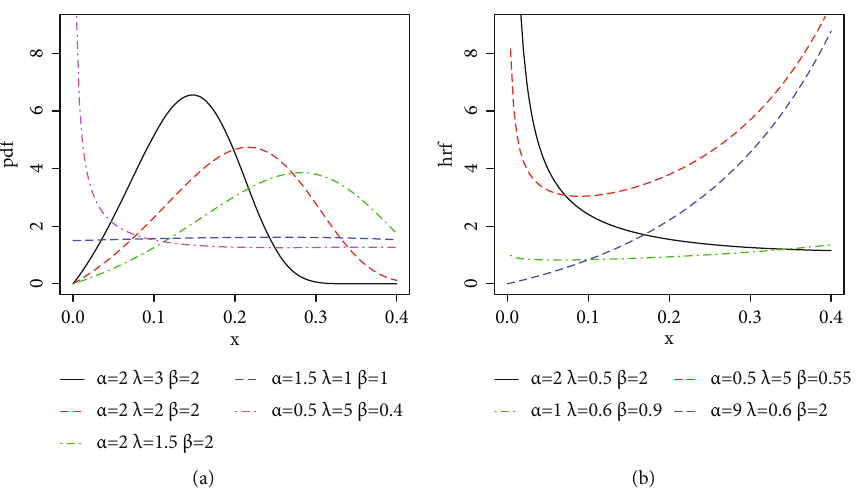
Figure 1: Plots of (a) UPWD density and (b) hazard function for random parametric